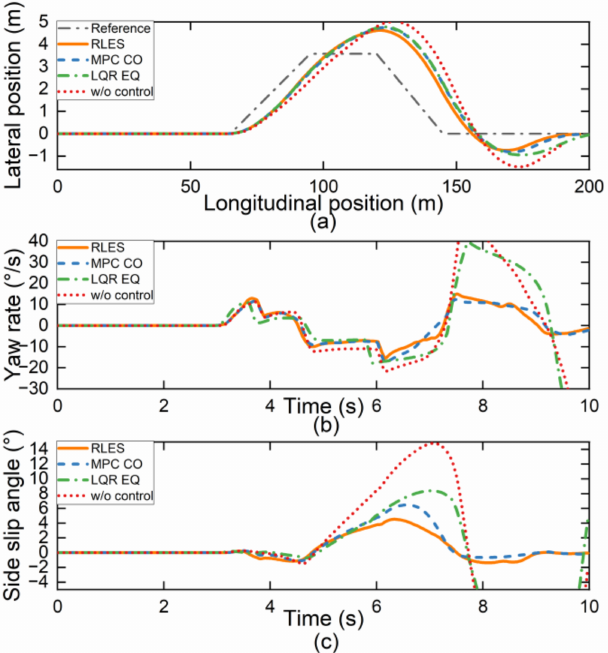
Figure 9. Simulation results under joint road. ( a ) Vehicle displacement; ( b ) yaw rate; ( c ) side slip